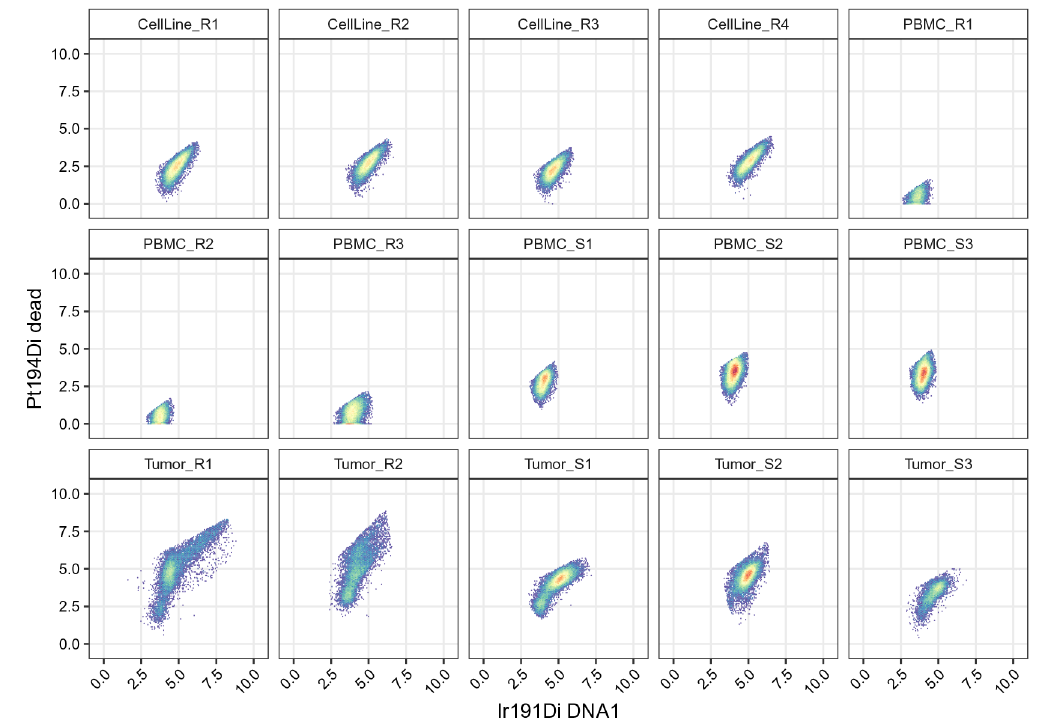
Figure 13. Scatter plots of dead cell channel against DNA, including the subset of cells remaining after live cell